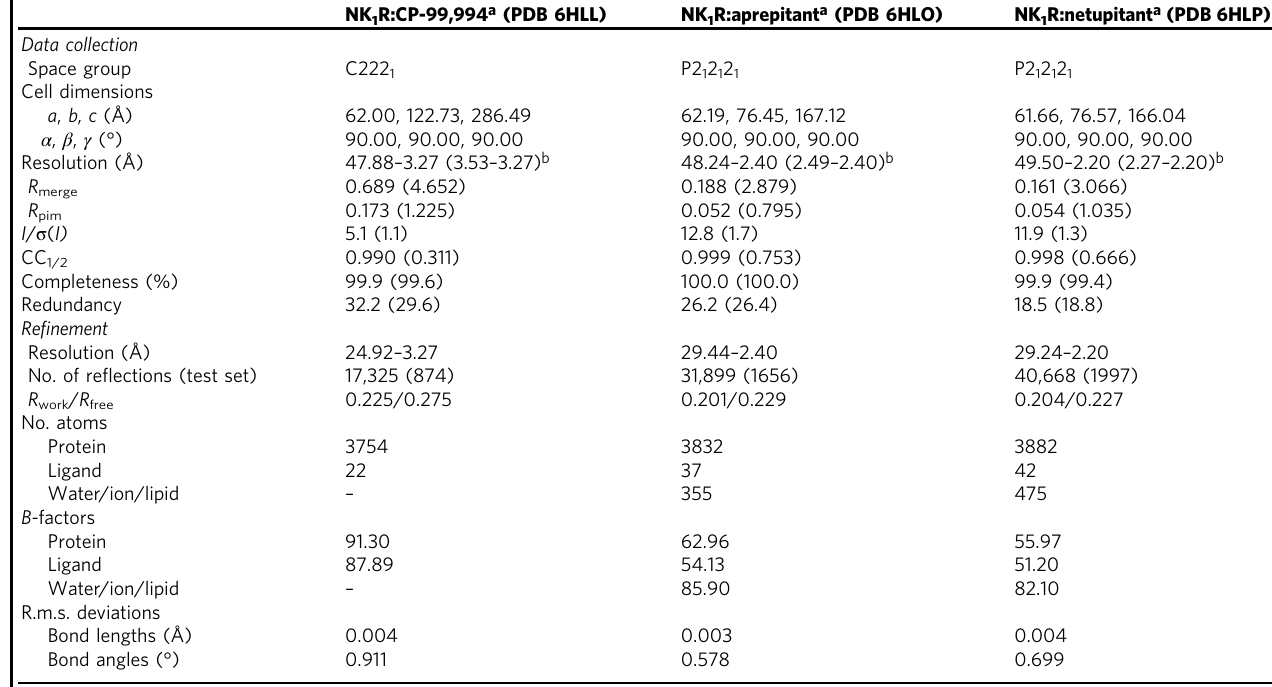
Table 1 Data collection and re fi nement